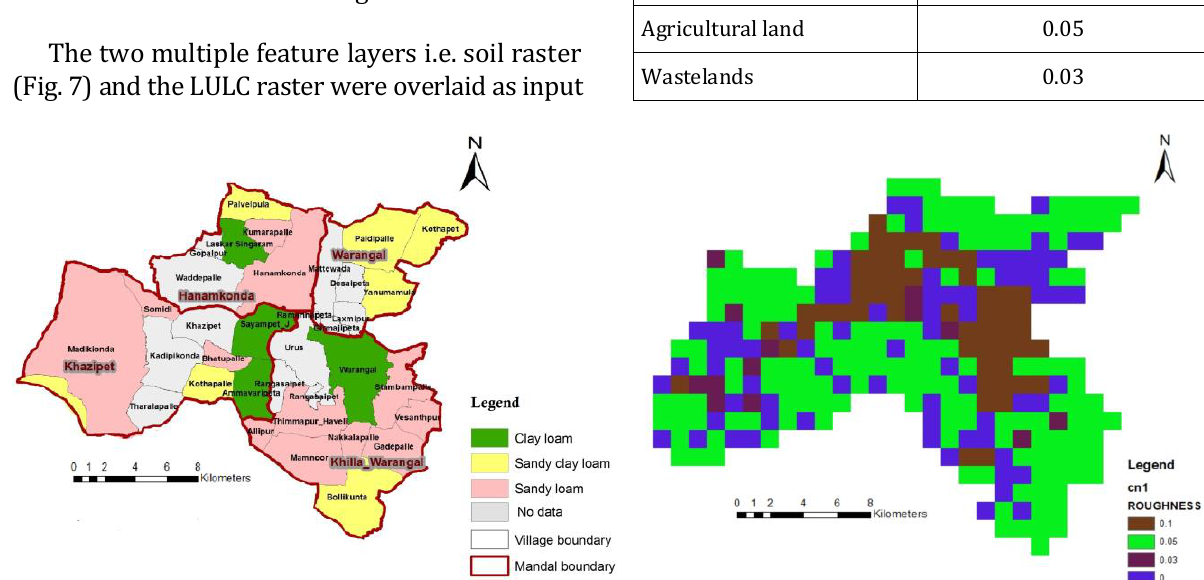
Fig. 7. Soil types present in the study area Fig. 8. Surface roughness